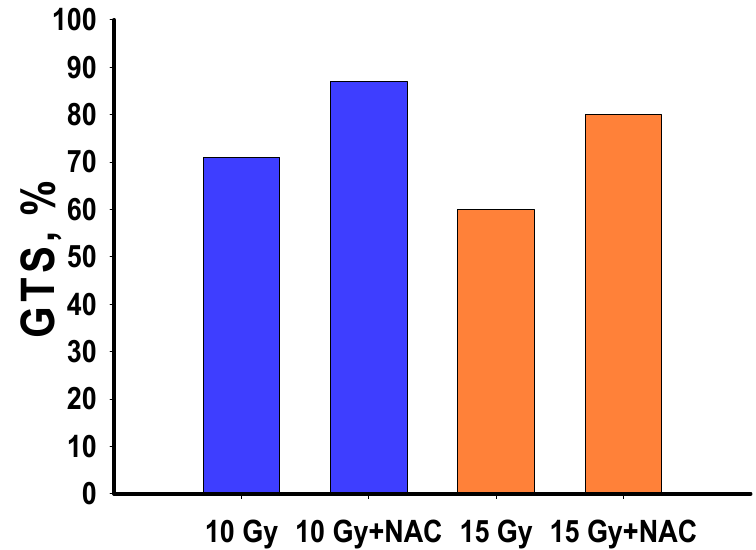
Figure 5. Genomic template stability (GTS) of planarians after X-ray irradiation (DNA was isolated 2 h after irradiation). GTS—genomic stability coefficient .